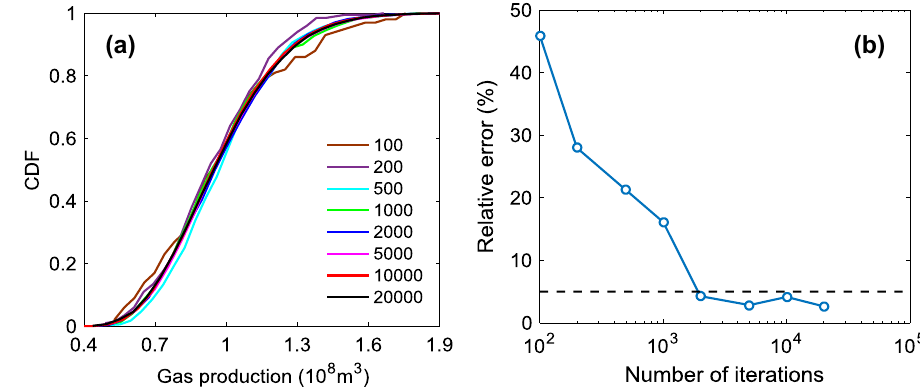
Fig. 4 CDF for different